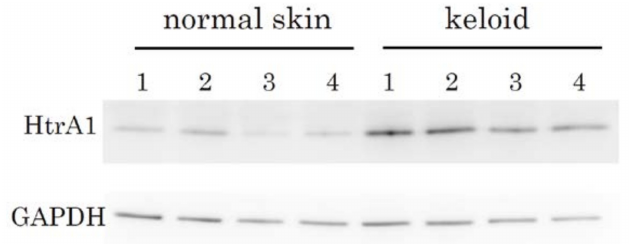
Figure 4. Western blot analysis of HtrA1 in keloid lesions and normal skin tissues. Soluble protein extract (8 µ g/lane) was analysed using specific antibodies against HtrA1 or glyceraldehyde-3-phosphate dehydrogenase (GAPDH). Keloid and normal skin samples from four different patients were analysed.